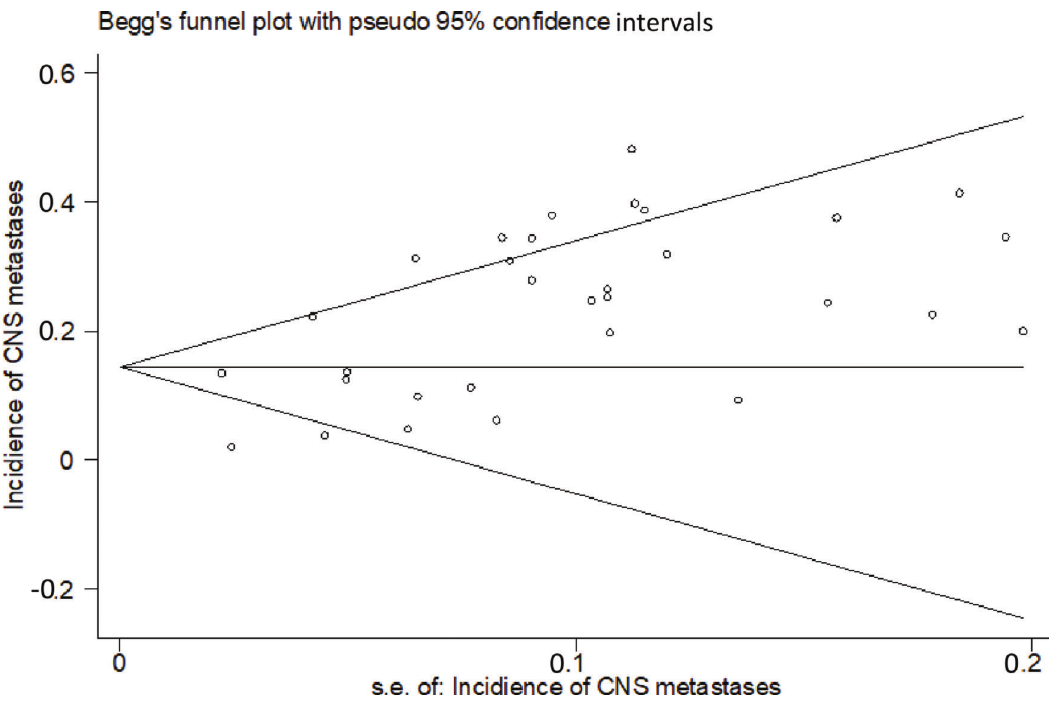
Figure S2 - Funnel plot showing the results of Begg ’ s test for publication bias assessment.